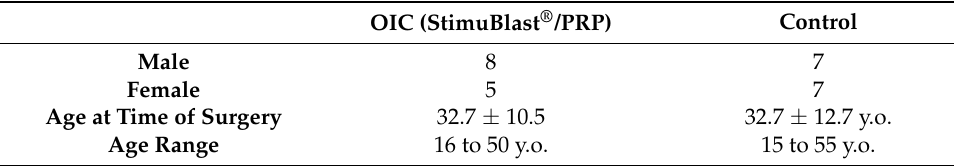
Table 1. Summary of the demographic data of